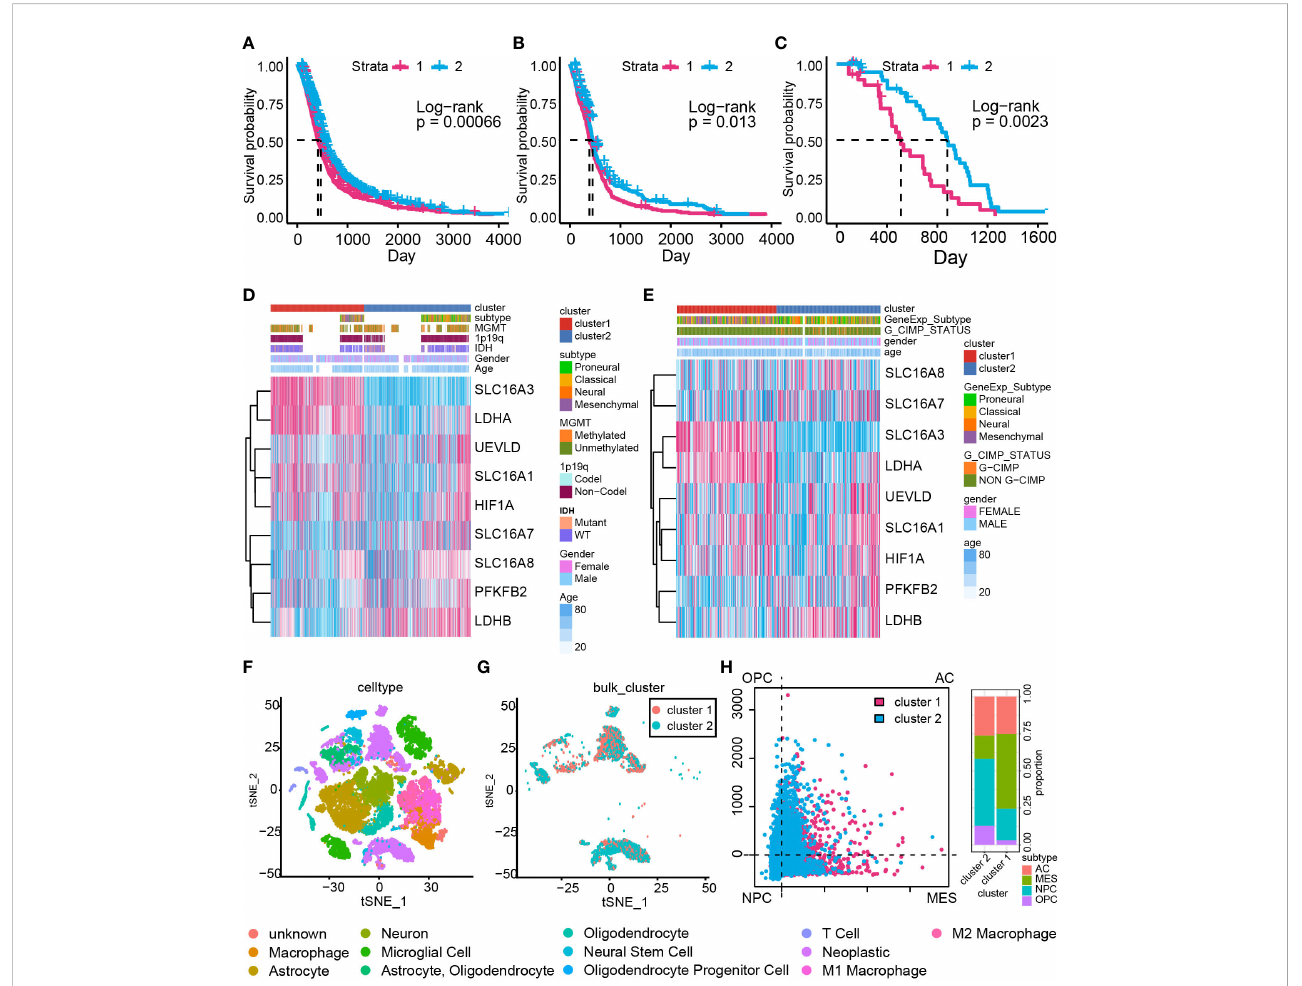
FIGURE 2 The cluster model based on LAGs. Overall survival analysis based on the GBM meta cohort (A) , TCGA GBM array cohort (B) , and Xiangya cohort (C) . The heatmap of LAGs in the GBM meta cohort (D) and TCGA GBM array cohort (E) along with clinical features. (F) Components of data from single-cell RNA- seq analysis. (G) The cluster model in data from single-cell RNA-seq analysis. (H) The percentage of MES-like, AC-like, OPC-like, and NPC-like cells in the cluster